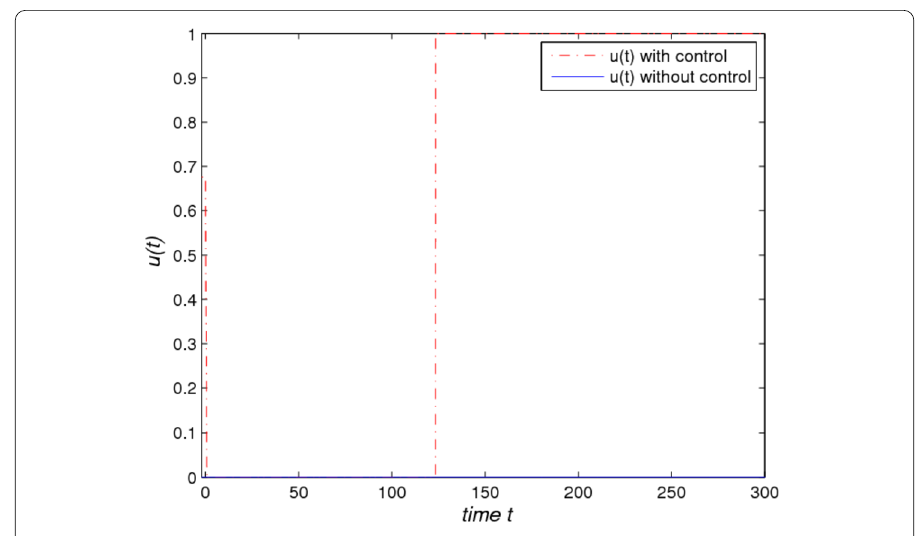
Figure 11 The behavior time plots of u